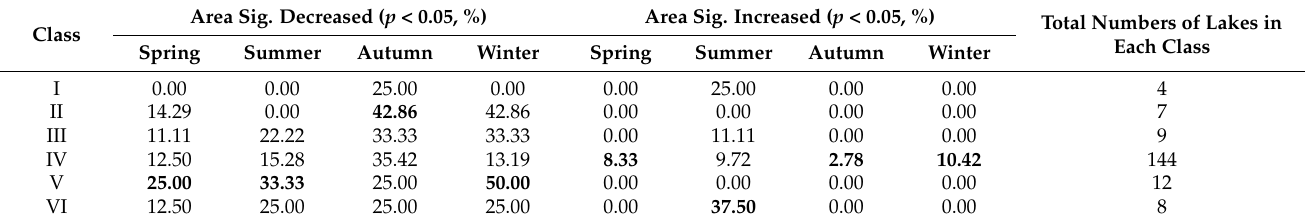
Table 4. Summary of percentages of lakes that exhibited significantly decreasing or increasing trends in seasonal inundation area in each season for different classes. Boldface denotes the maximum